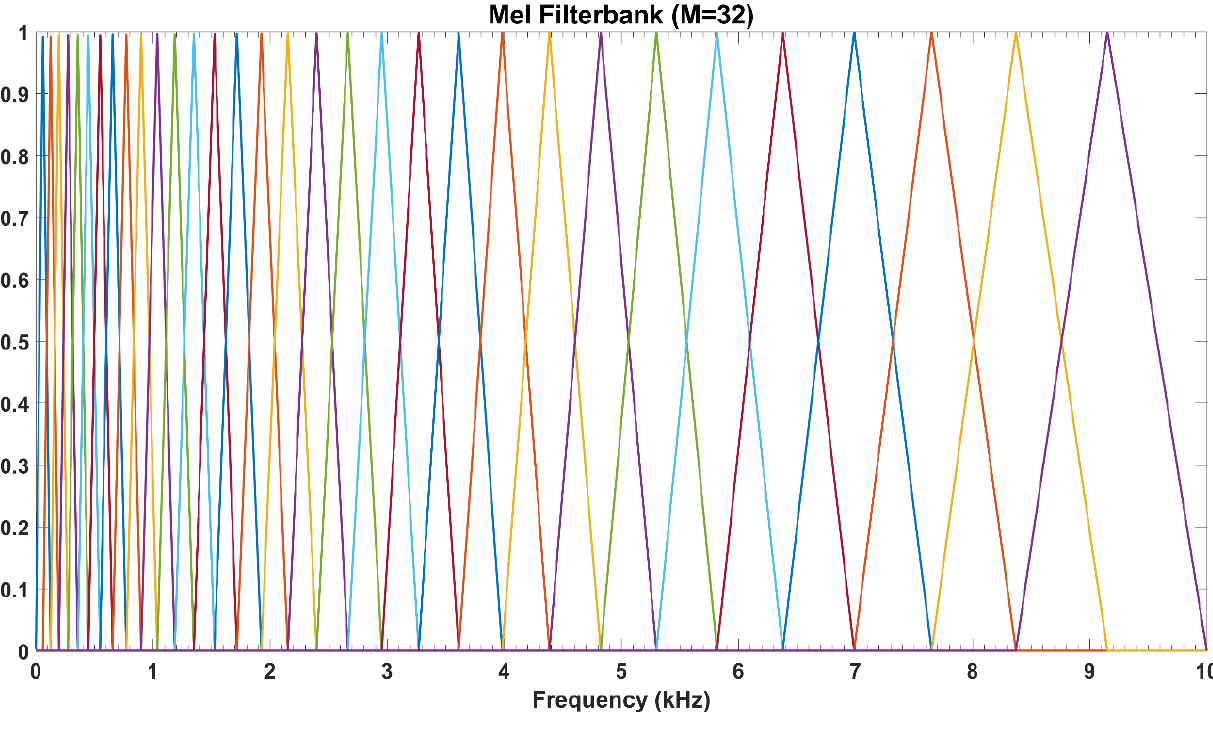
Figure 4. The triangular mel-frequency scaled filter-banks.